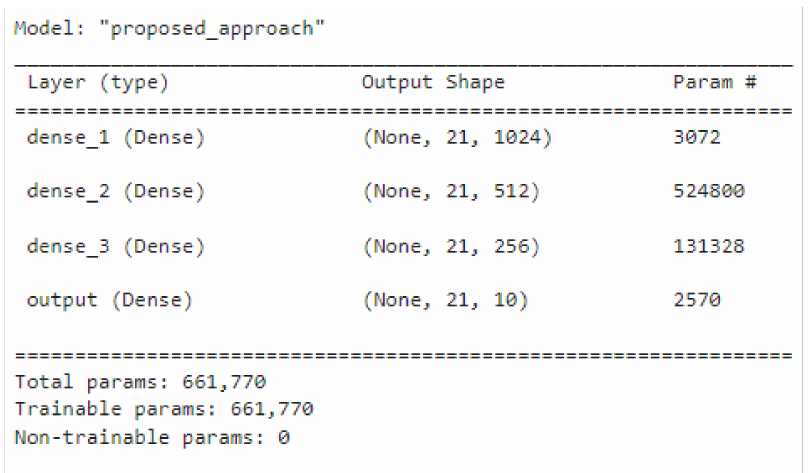
Figure 13. The classification model in our proposed method.